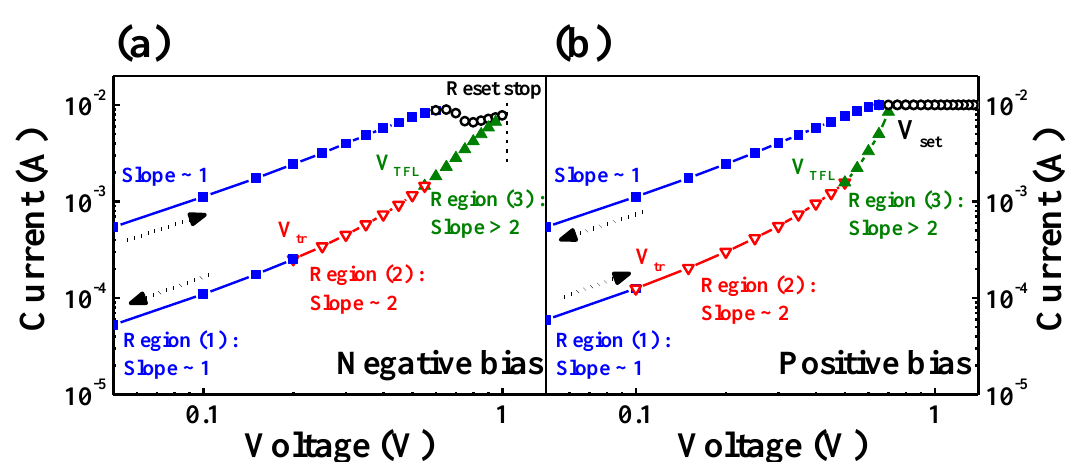
Figure 6. Current conduction mechanism for IGZO:N memristor devices by double-logarithmic-plotted BRS I–V characteristic curves: ( a ) negative bias and ( b ) positive bias regions.